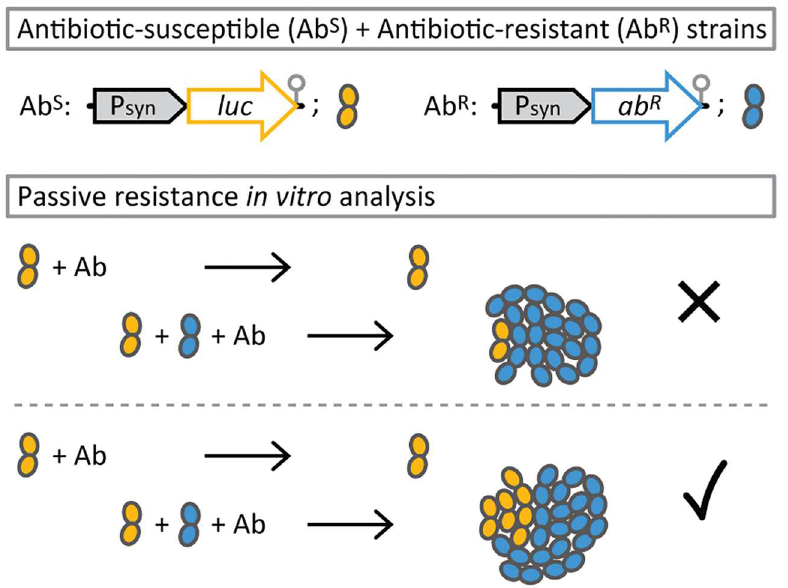
Fig 1. Experimental setup to determine passive resistance. Antibiotic-susceptible cells (Ab S ) constitutively expressing luc are grown together with antibiotic-resistant cells (Ab R , which do not express luc ). Only when the concentration of the antibiotic in the medium is reducedby enzymatic deactivationof resistant cells will the genetically antibiotic-susceptible cells be able to grow and